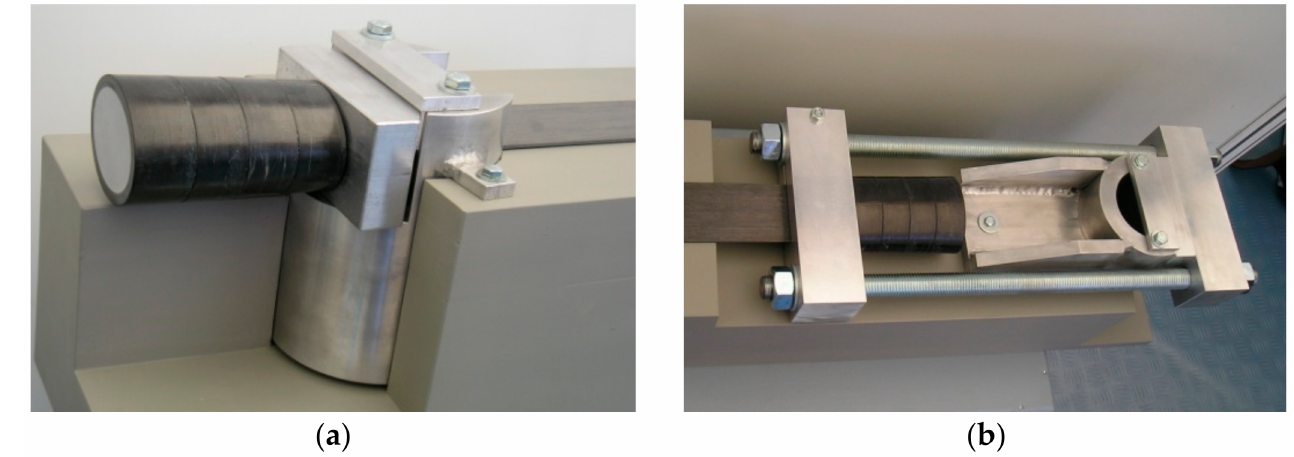
Figure 2. ( a ) StressHead passive anchorage and ( b ) StressHead active